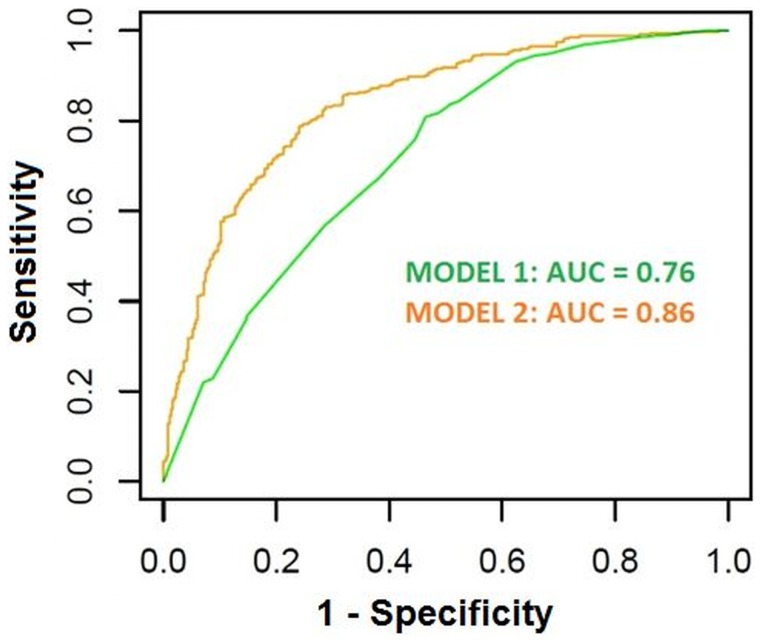
Receiver Operating Curves (ROC) for the two multivariate models including asbestos exposure 1) without and 2) with the 10 most robust and significant genetic variants.